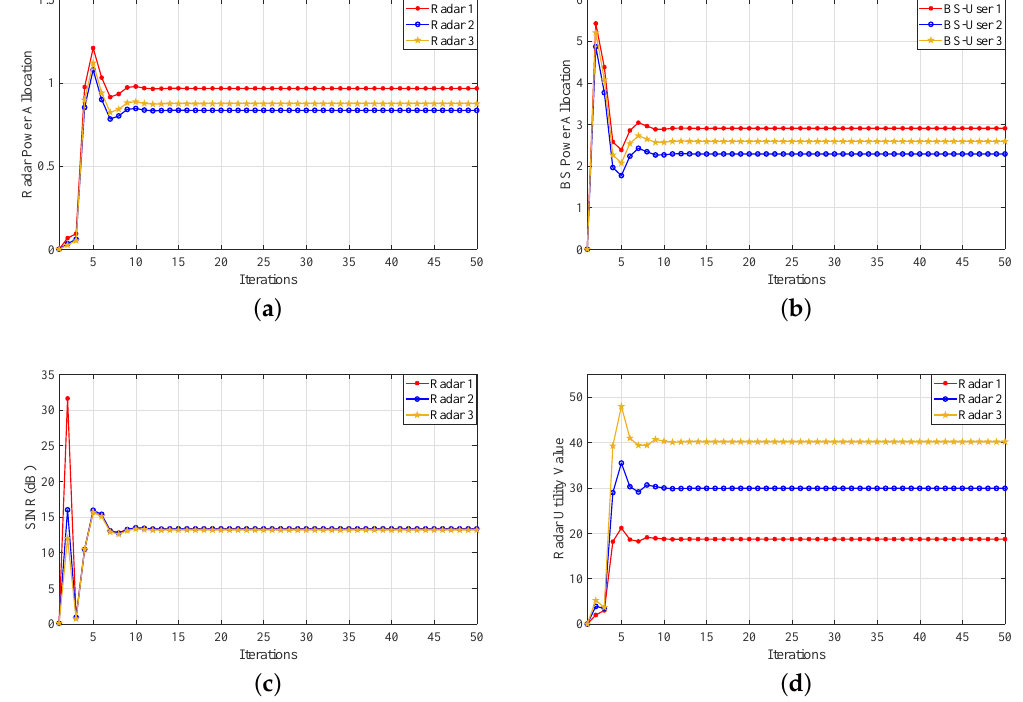
Figure 4. Stackelberg PAG Algorithm 1. ( a ) Power allocation convergence for multistatic MIMO radar. ( b ) Power allocation convergence for BS. ( c ) SINR convergence for multistatic MIMO radar. ( d ) Utility value convergence for multistatic MIMO radar.